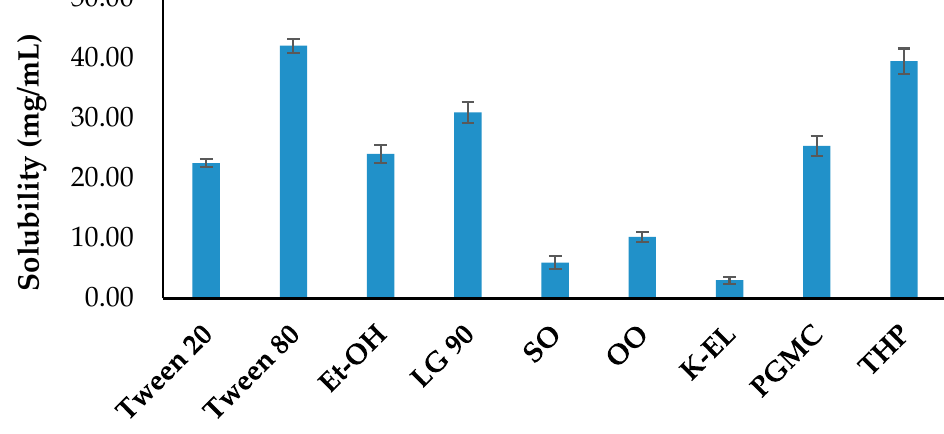
Figure 1. Solubility profile of DSM in different components.